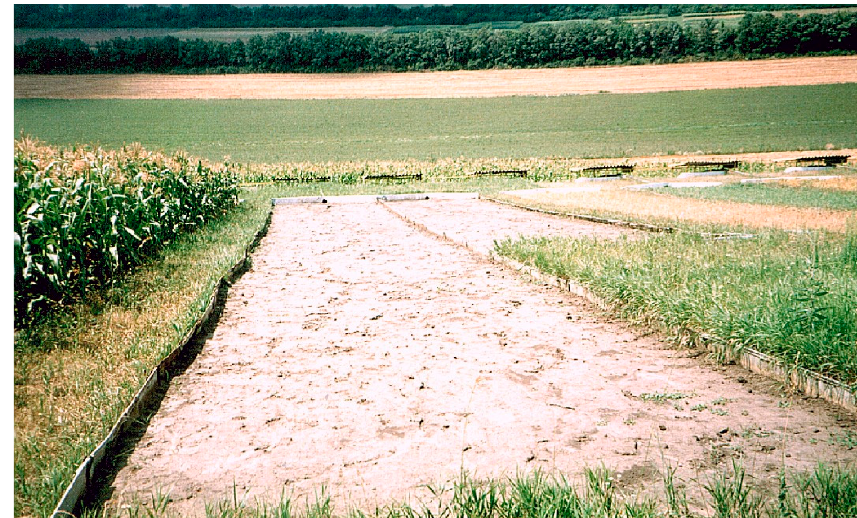
Figure 2. Standard plots for drain control overview. Source: [ 7]